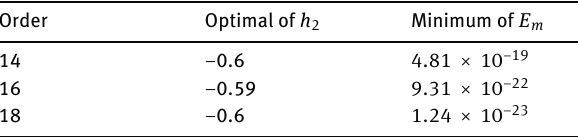
Table 3: Optimal value of h 2 at different order of approximations Order